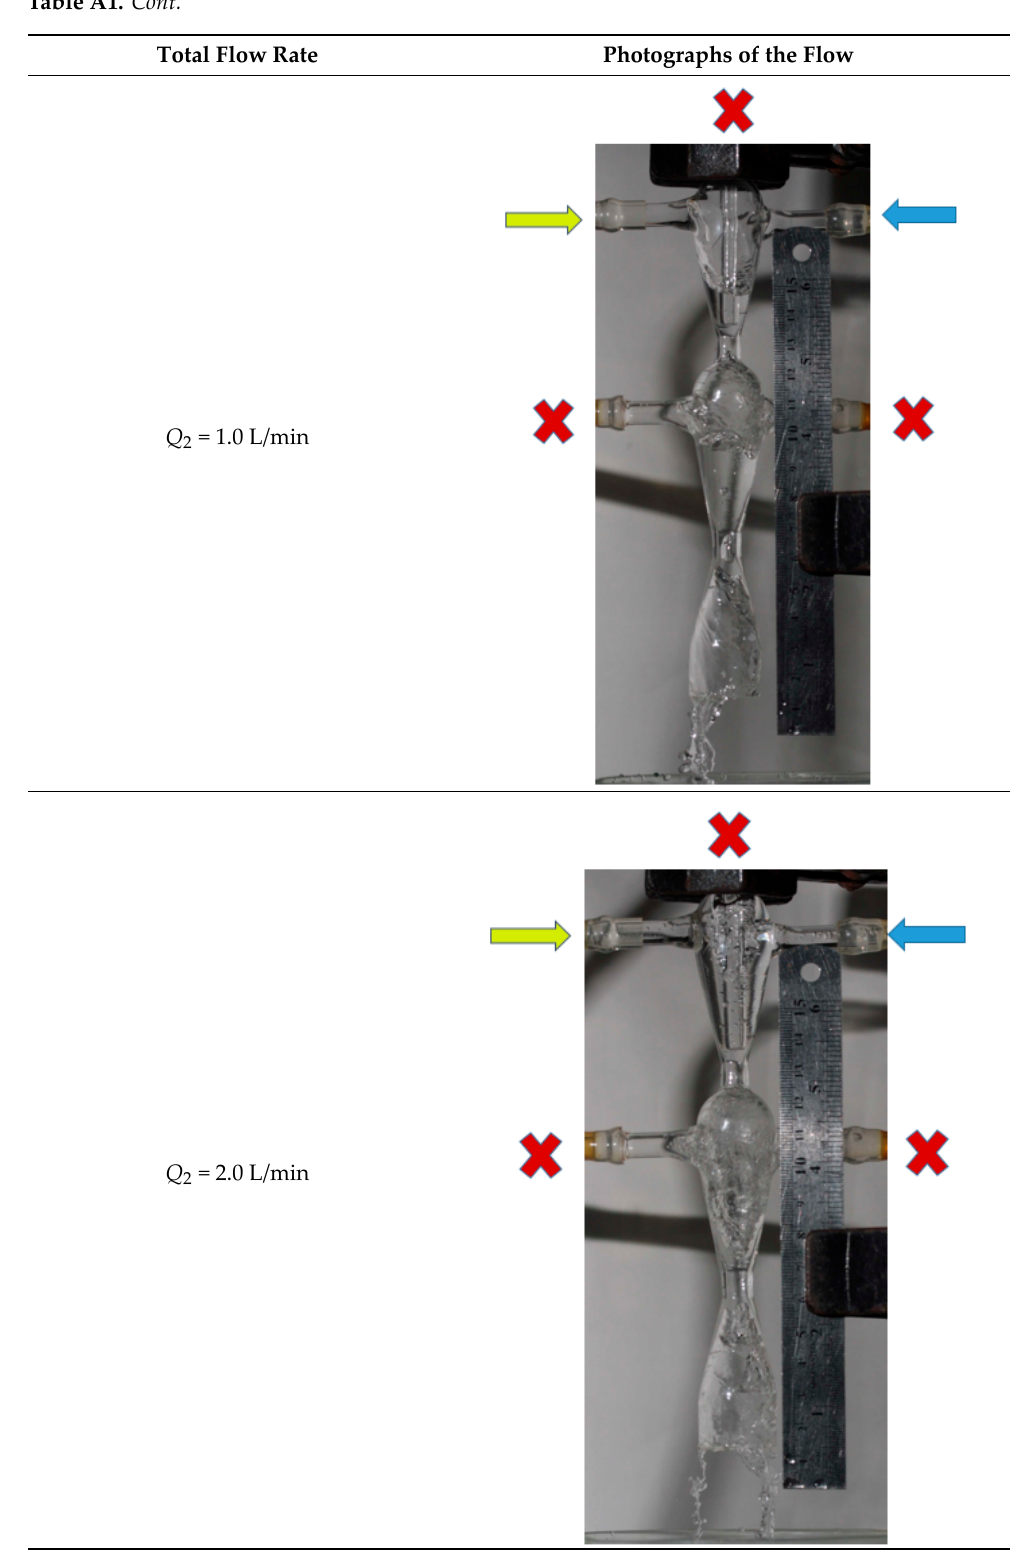
Table A1. Cont. Table A1. Photographs of the flow in MRISF ‐ 2 for liquids supply method (TU1,